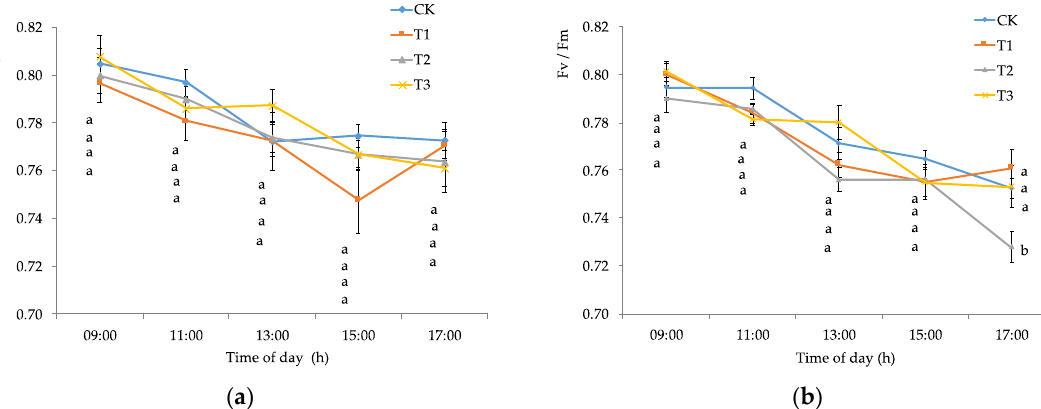
Figure 3. Variation of maximum quantum yield of photosystem II (Fv/Fm) in calafate plants ( Berberis mycrophilla G. Forst) for the different compost treatments, evaluated at different times of the day, 09:00, 11:00, 13:00, 15:00 and 17:00, corresponding to the figure: ( a ) season 2018–2019; ( b ) season 2019–2020. For each figure: CK = Control treatment (without compost application); T1 = Treatment 1 (5 Ton ha − 1 ); T2 = Treatment 2 (10 Ton ha − 1 ); T3 = Treatment 3 (15 Ton ha − 1 ). For each hour of the day, different lowercase letters indicate significant differences between treatments according to Fischer’s LSD test ( p < 0.05). The bars correspond to the experimental error of each treatment. In Figure 4, it is possible to observe the registered values of the stomatic conductance (mmol m − 2 s − 1 ) of the calafate leaf at different hours of the day and for different compost dose treatments. Highlighting that, for the 2018–2019 season, no significant differences were observed among treatments, with average values of 260, 289, 308, and 291 mmol m − 2 s − 1 ( p > 0.05) for CK, T1, T2, and T3, respectively. However, for the control treatment, from 11:00 until the end of the day, Gs values were always above 260 mmol m − 2 s − 1 unlike the rest of the treatments, which, after obtaining the maximum values of stomatal conductance, their values decreased by up to 40% (data not shown). For the 2019/2020 season, the same trend was observed as in the 2018/2019 season. However, recorded values were slightly lower than the previous season, with averages of Gs for CK, T1, T2, and T3 of 227, 214, 257, and 230 mmol m − 2 s − 1 ( p > 0.05), respectively.